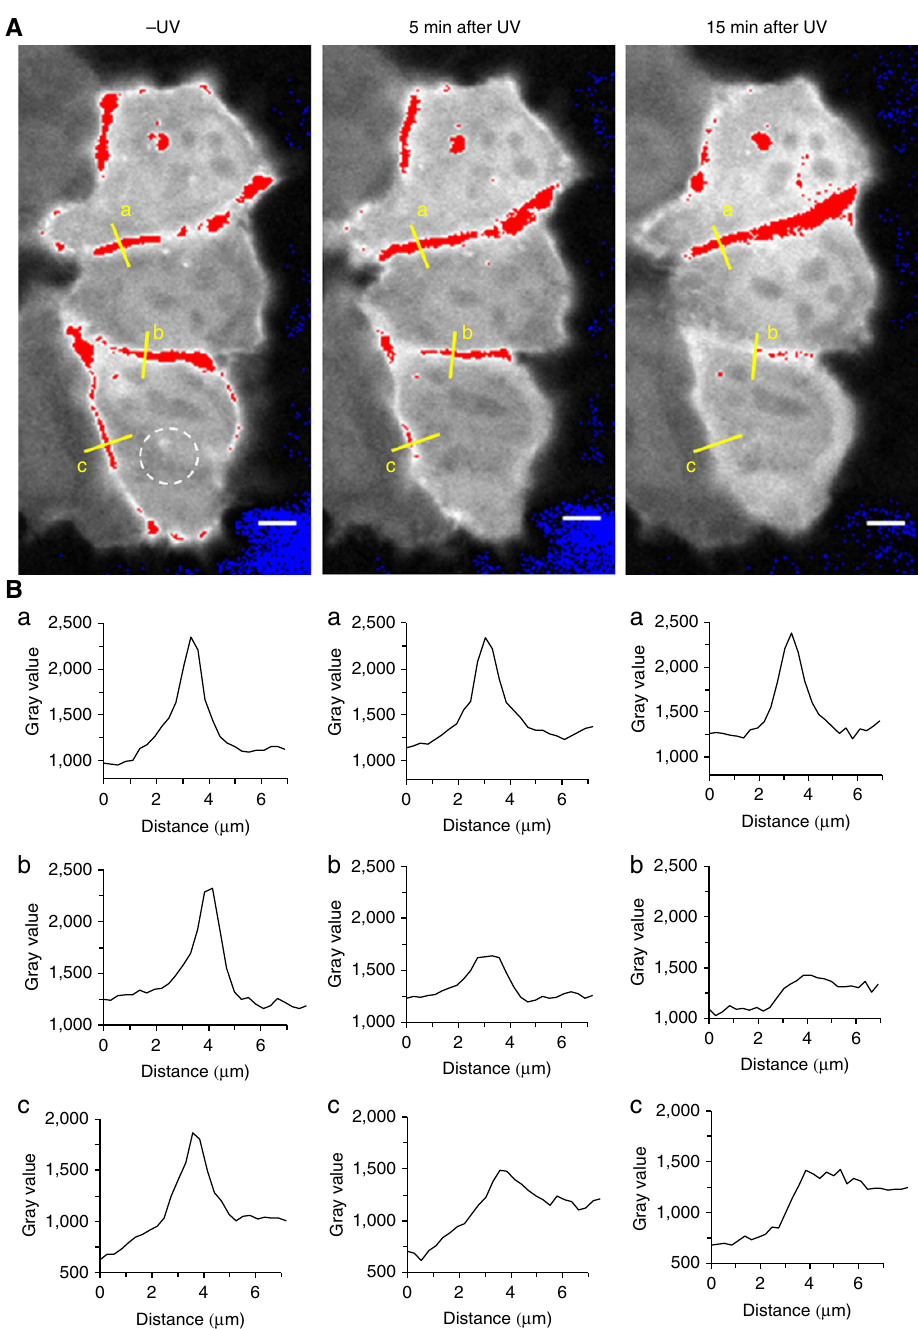
Figure 6 | PH-domain translocation in irradiated and control cells. Confocal fluorescence microscopy analysis of PH–eGFP translocation in HeLa Kyoto cells after photouncaging in defined areas (dotted circle). ( A ) Serum-starved cells were loaded with 5 m M 9 þ 11 for 4h and then stimulated with IGF and EGF (100ngml (cid:2) 1 ). Robust recruitment of the PH-domain to the membrane is observed. Photouncaging in the dotted area (white circle) is achieved by short ultraviolet laser pulses and the change of fluorescence intensity followed over time (0, 5 and 15min). ( B ) Development of the fluorescence intensity (indicated as gray value) over time (0, 5, 15min) in three different membrane sections (a, b, c; distance in m m). Photouncaging leads to translocation of the PH–eGFP construct into the cytoplasm after 5min from the membrane of the irradiated cell. After 15min, complete translocation of the PH-domain into the cytoplasm is observed ( B , b and c), whereas in the non-irradiated control cell the PH–eGFP construct remains localized on the membrane ( B , a). Images are presented in pseudo-colour, normalized over time. Intensities were acquired pre-saturated, with the entire dynamic range of intensity available. Scale bars, 5 m